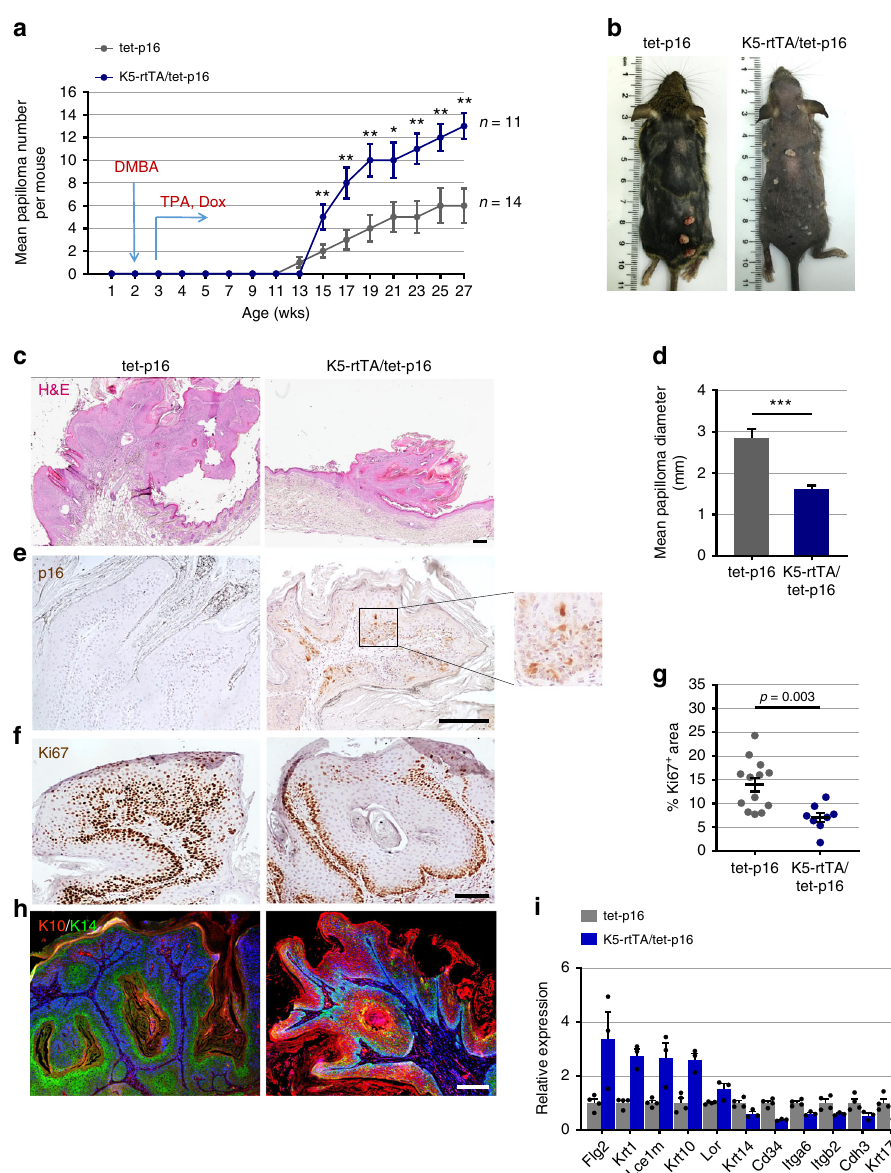
Fig. 3 p16 promotes carcinogen-induced papilloma formation but slows lesion growth. a Average number of papillomas per mouse formed over time (age in weeks) in K5-rtTA/tet-p16 and sibling control tet-p16 mice treated once with DMBA at 3 weeks, followed by continued TPA treatment and p16 activation by dox starting at 4 weeks. n = 14, 11 mice per group combined from four independent experiments. b Images of indicated mice at 27 weeks of age, showing papillomas formed on back skins. c H&E staining of papillomas from control and p16-induced mice. d Mean diameter of papillomas from the same mice at 27 weeks. n = 84, 136 papillomas per group. e Immunostaining for p16 (brown) in papillomas from same mice. Enlarged inset is shown on right. f Staining for Ki67 (brown) in papillomas from same mice. g Percentage of Ki67-stained area of the epithelial component of papillomas (dots) from indicated mice, scored by image analysis. n = 13,8 in respective groups. h Papillomas from control and p16-induced mice stained for K14 (green) and K10 (red), marking the basal and suprabasal layers, respectively. i Relative mRNA levels of epidermal differentiation-associated genes in whole papillomas from control and p16-expressing mice, measured by mRNA-seq. n = 4, 3. P < 0.05 for all genes. Graphs indicate mean values across mice ( a ) or across lesions ( d , g , i ) ± S.E.M. * P < 0.01, ** P < 0.001, *** P < 0.0001, t test. Scale bars — 200 μ m, except f — 100 μ